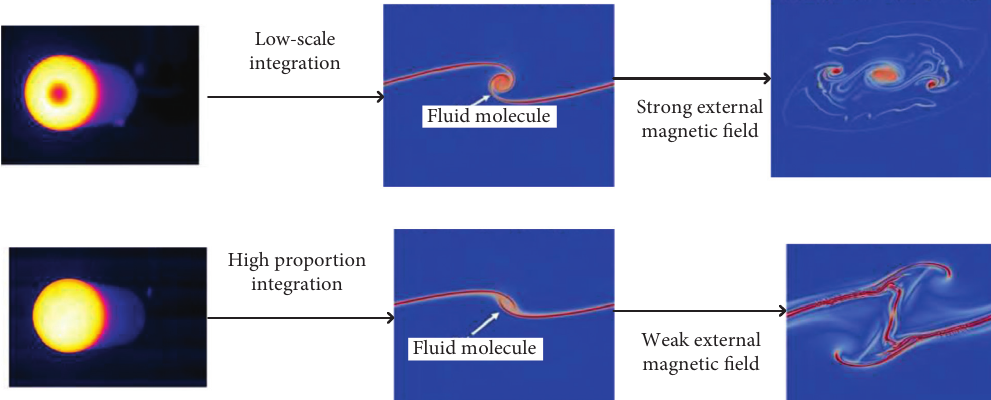
Figure 3: Magnetic fluid dense and sparse electric field